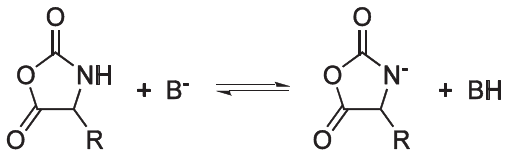
elimination as a result of the attack of a primary amine on a 2